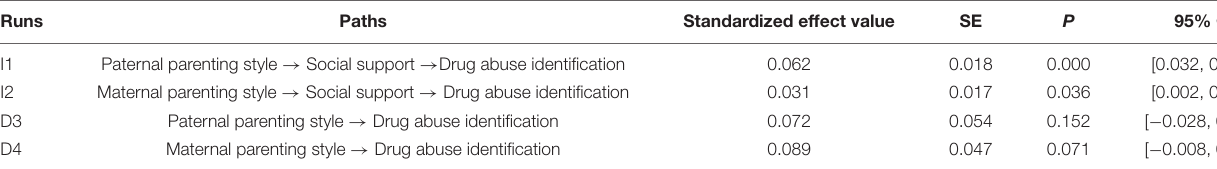
TABLE 4 | Bootstrap test for significance of the main effect size of the structural model.